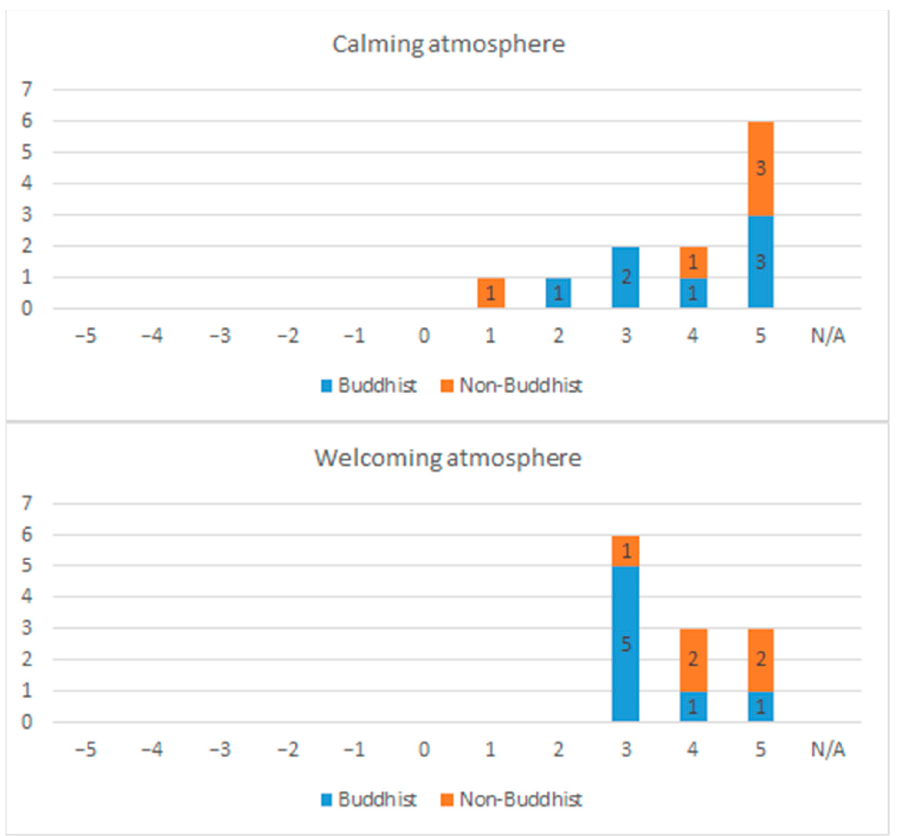
Figure A1. Results from responses to the question: “At this moment in time, please rate whether the following physical elements have a positive, negative or neutral influence on your mindfulness meditation practice, where − 5 = very negative influence, 0 = neutral, and +5 = very positive influence. If the element is not present in the space where you practice the most, please select n/a”.